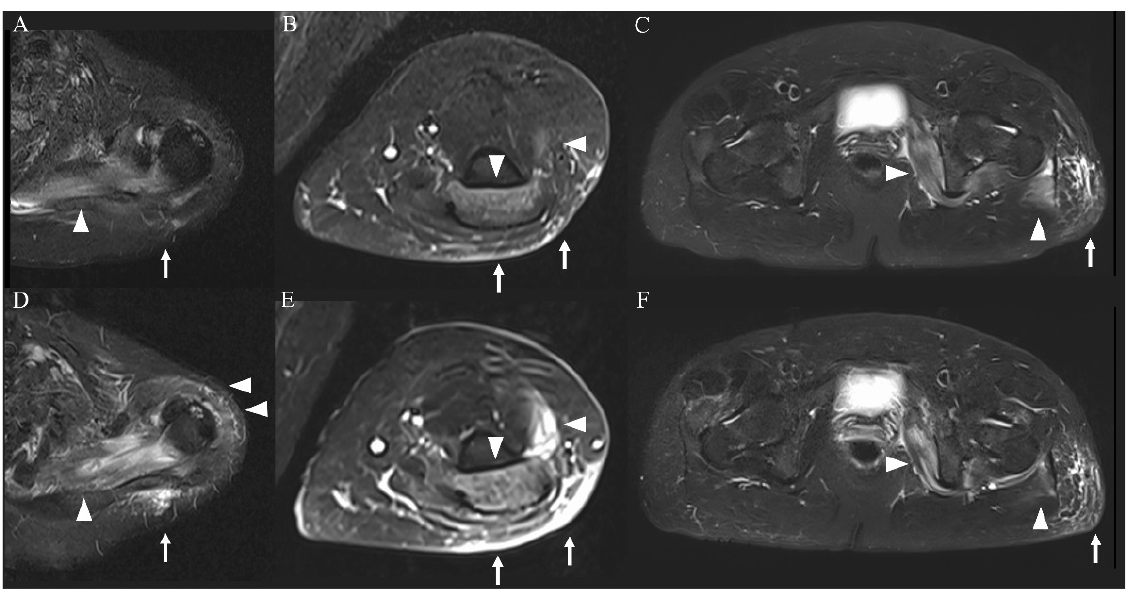
Figure 2. MRI of the extremities (short-tau inversion recovery images). Imaging on admission showed a high-intensity area in the left dominant bilateral triceps brachii, left supraspinatus, deltoid, internal obturator, and gluteal muscles (( A – C ), arrowheads) and subcutaneous tissue (( A – C ), arrows). These findings were more severe in the upper limb muscles (( D , E ), arrowheads and arrows) and were attenuated in the lower limb muscles (( F ), arrowheads and arrows) on day 4 of hospitalization.